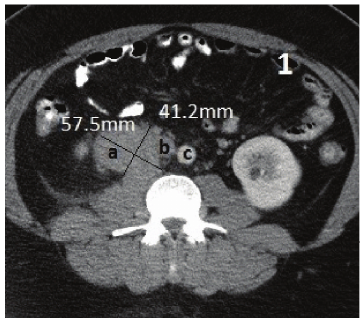
Figure1:AbdomenCTaxialview:(a)inferiorvenacava(IVC)varix measuring 57.5 mm × 41.2 mm, (b) IVC, and (c) aorta.